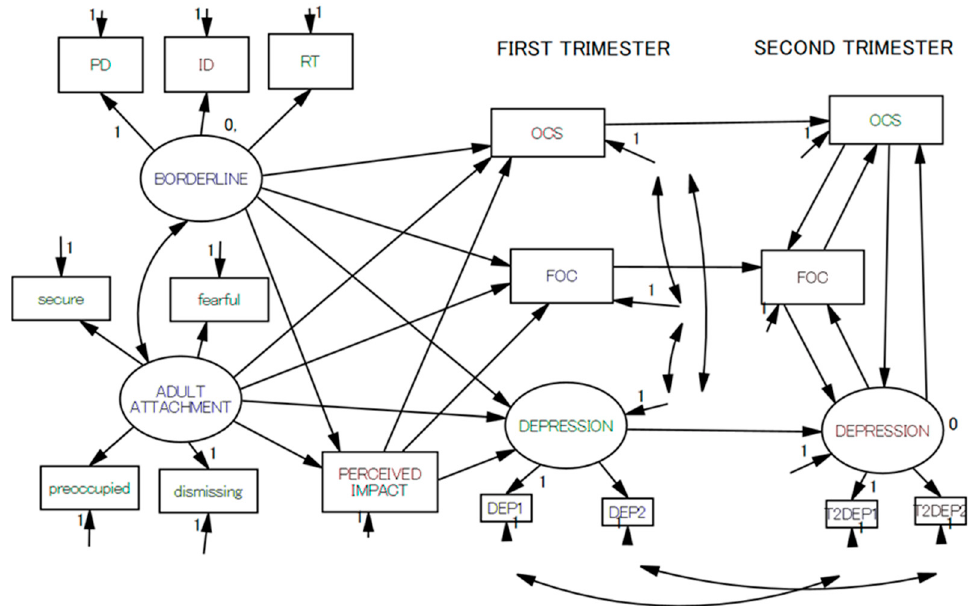
Figure 1. Conceptual model of causal relationships between antenatal depression.